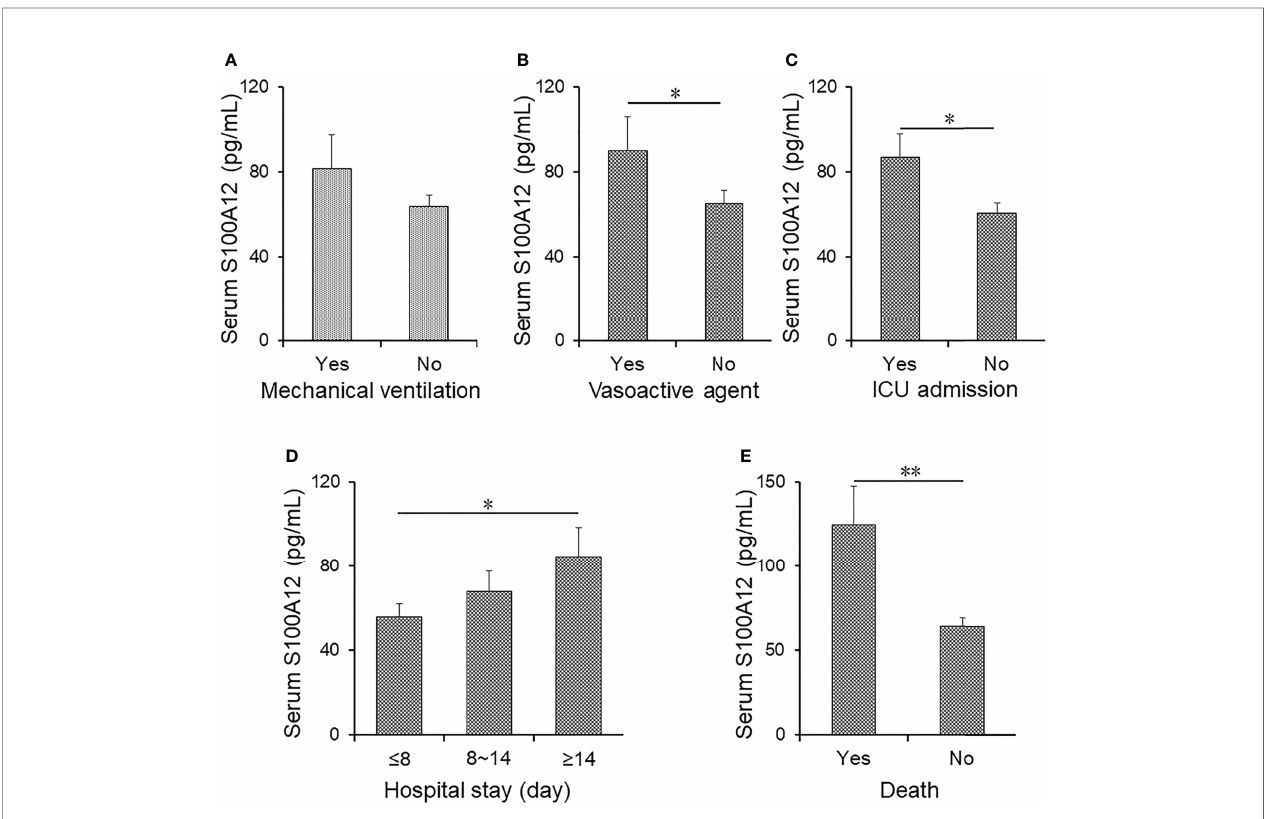
FIGURE 2 | The levels of serum S100A12 in different prognostic outcomes of CAP patients. (A – E) The level of serum S100A12 was detected via ELISA in CAP patients. (A) The level of serum S100A12 in CAP patients with or without mechanical ventilation. (B) The level of serum S100A12 in CAP patients with or without vasoactive agent. (C) The level of serum S100A12 in CAP patients with or without ICU admission. (D) The level of serum S100A12 in CAP patients with different hospital stays. (E) The level of serum S100A12 in alive and dead CAP patients. Data were expressed as mean ± SEM. * p < 0.05, ** p < 0.01.